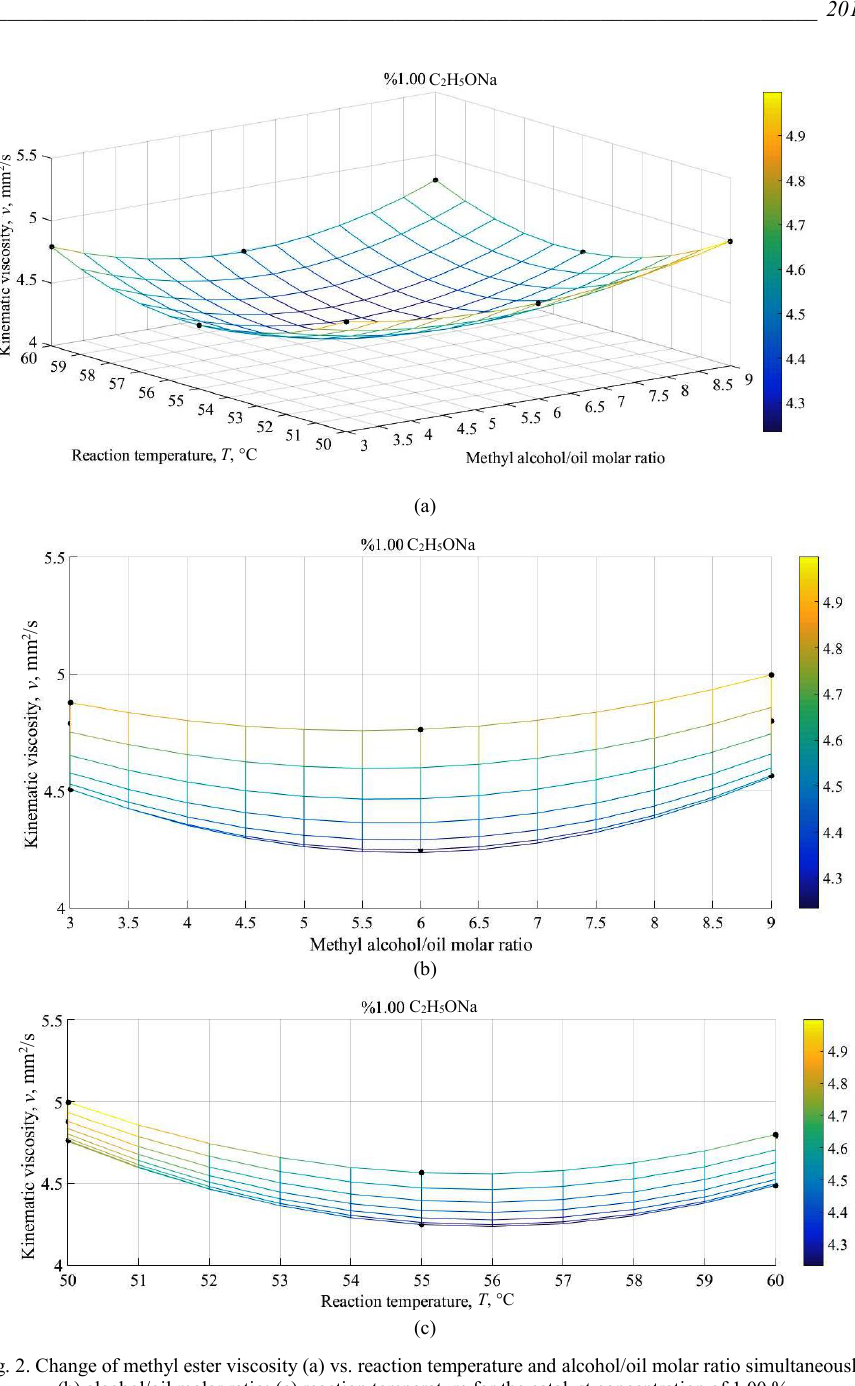
Fig. 2. Change of methyl ester viscosity (a) vs. reaction temperature and alcohol/oil molar ratio simultaneously; (b) alcohol/oil molar ratio; (c) reaction temperature for the catalyst concentration of 1.00